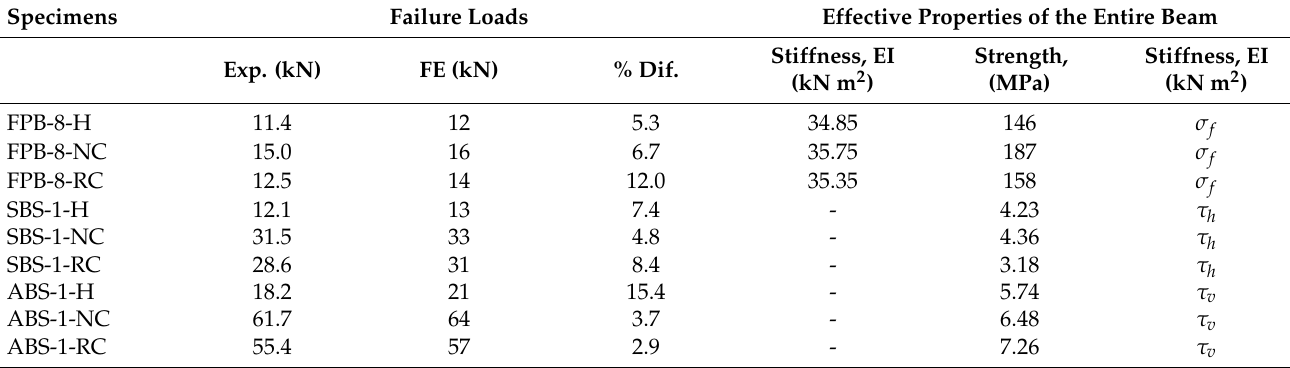
Table 4. Comparison between experimental and FE failure loads, and evaluation of